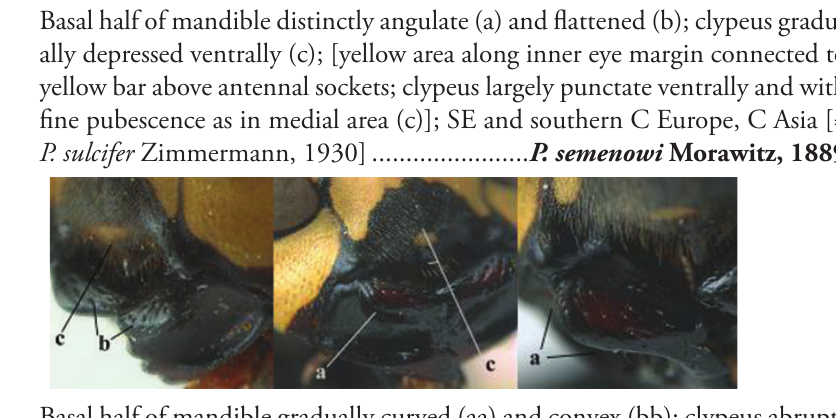
– Basal half of mandible gradually curved (aa) and convex (bb); clypeus abrupt- ly depressed ventrally (cc) ........................................................................... 7